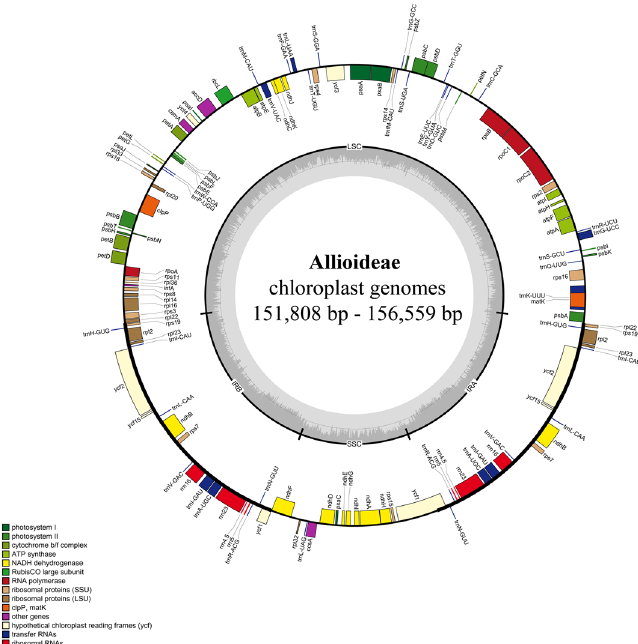
Figure 1. Representative map of the plastid genome of Allioideae species. Genes inside the circle are transcribed clockwise, whereas those outside the circle are transcribed counter-clockwise. LSC large single copy, SSC small single copy, IRA-IRB inverted repeat